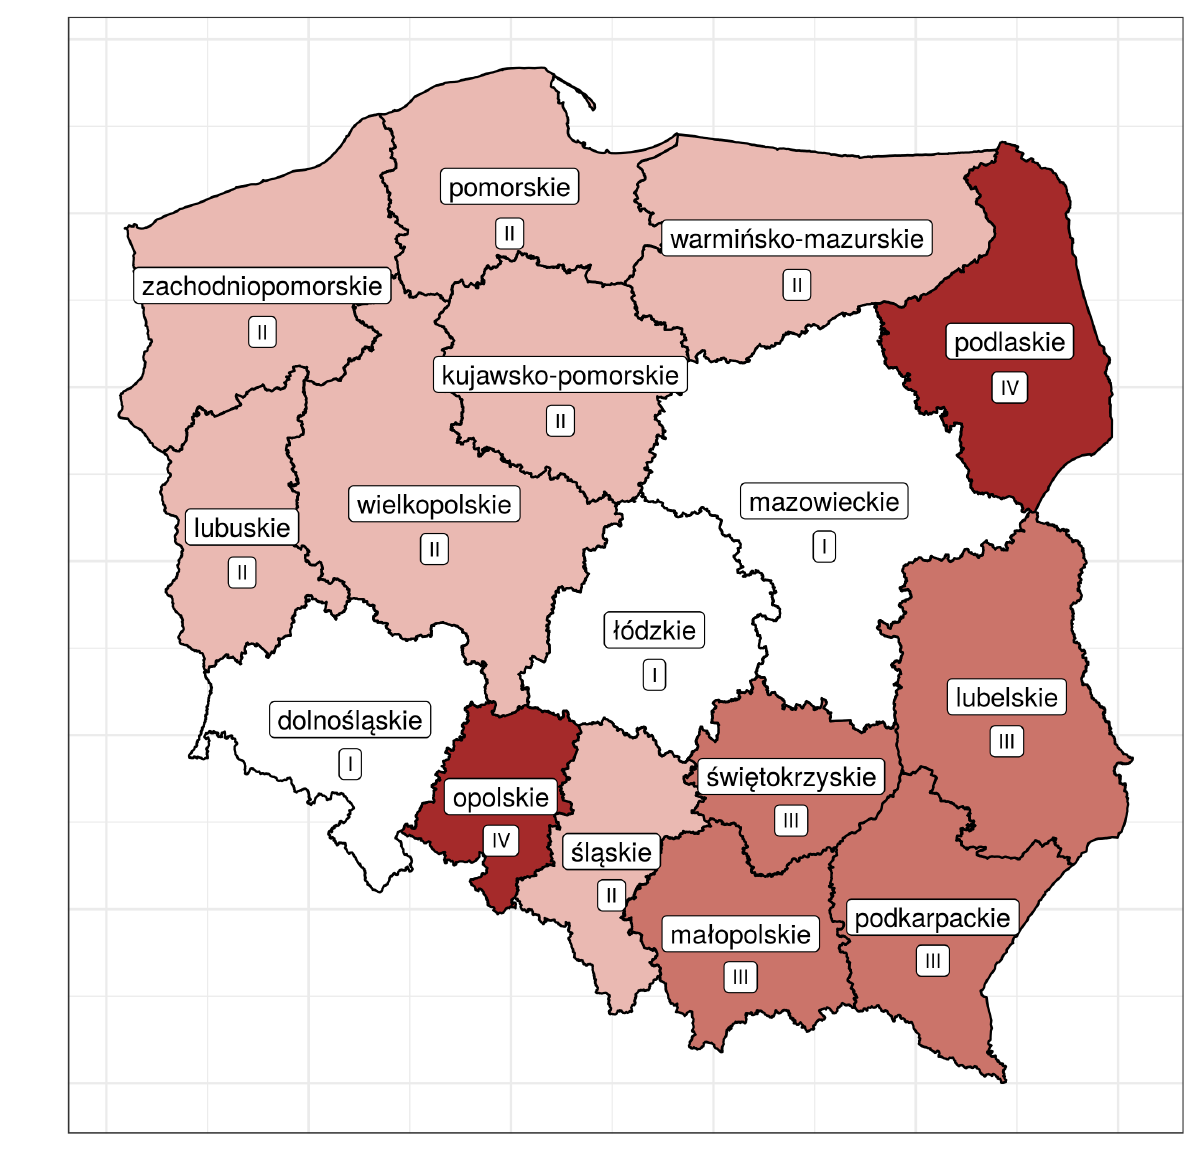
Figure 6. Spatial variation in the health situation across the provinces of